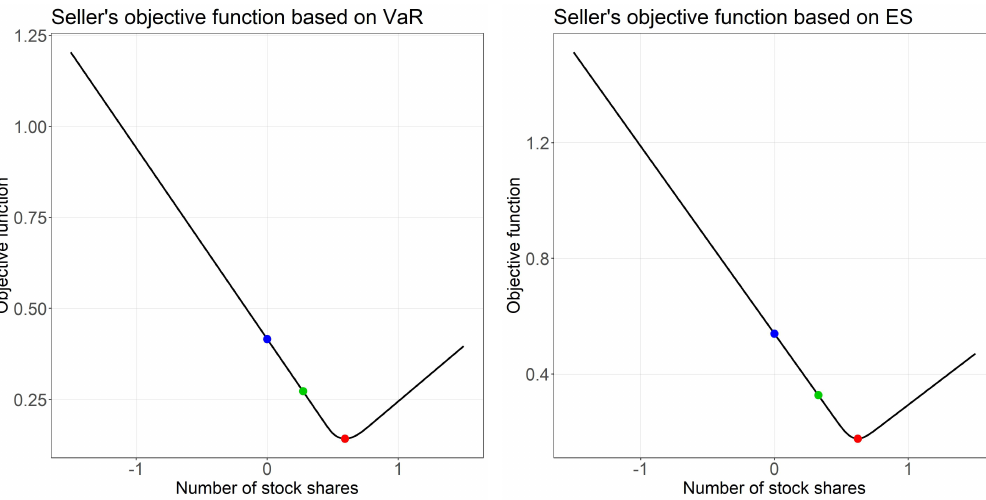
Figure 2. Capital requirements depending on the number of stock